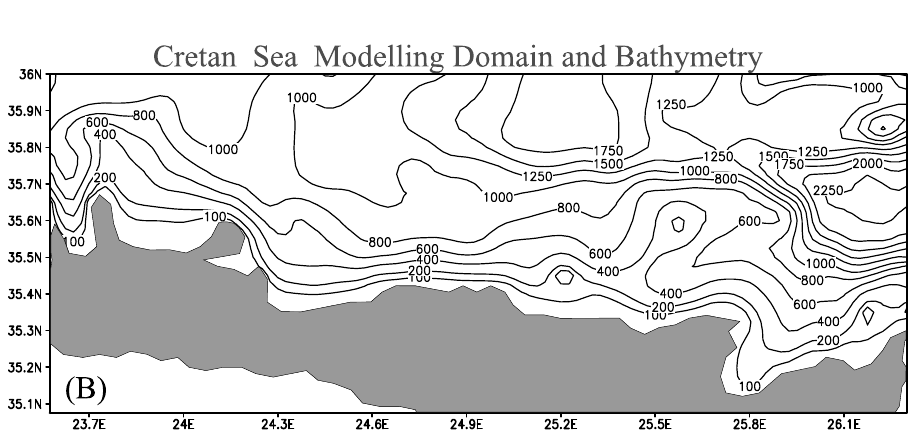
Fig. 1. (a) Map of the wider area of the Cretan Sea. (b) Model domain and